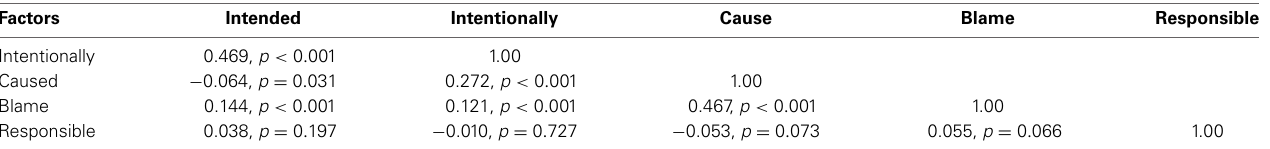
Table 3 | Partial correlations of the five factors with each other.